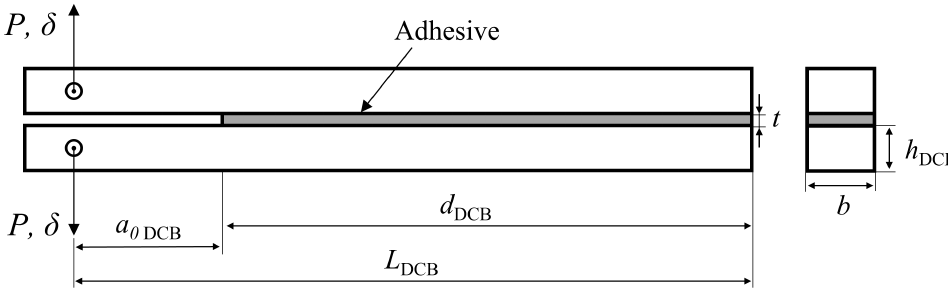
Figure 1. Schematic representation of the DCB specimen and its associated testing